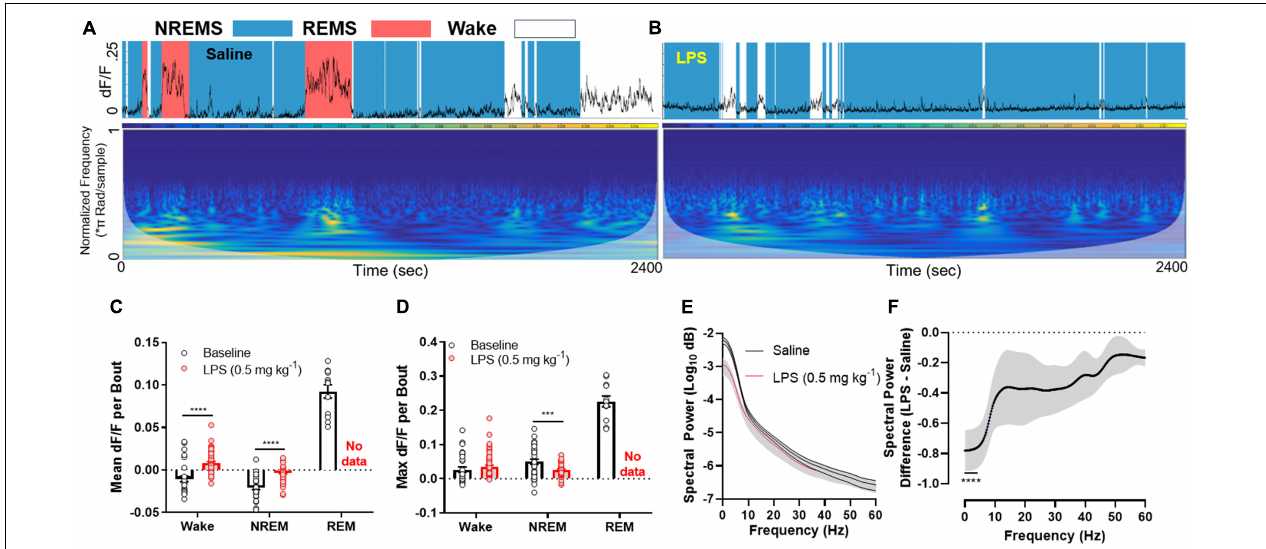
FIGURE 2 | LPS rapidly silences LH GABA neurons. (A) Representative GCaMP6s trace and scaleogram from a mouse 40 min following a saline injection. The trace is shaded by the arousal state the animal was in at the time (based on EEG/EMG recordings), where blue = NREM sleep, red = REM sleep, and white = wakefulness. The colormap for the scaleogram represents the power. (B) representative GCaMP6s trace and scaleogram from the same mouse 40 min following a 0.5 mg kg - 1 LPS IP injection. Note the absence of high amplitude GCaMP signal in tandem with loss of REM sleep. (C) quantification of all data in the experimental set showing the mean dF/F per bout between baseline and LPS groups (wakefulness: t -ratio = 8.239, adjusted p < 0.0001; NREM sleep: t -ratio = 6.057, p < 0.0001). (D) quantification of all data in the experimental set showing the max dF/F per bout between baseline and LPS groups (NREM sleep: t = 4.020, p < 0.001)